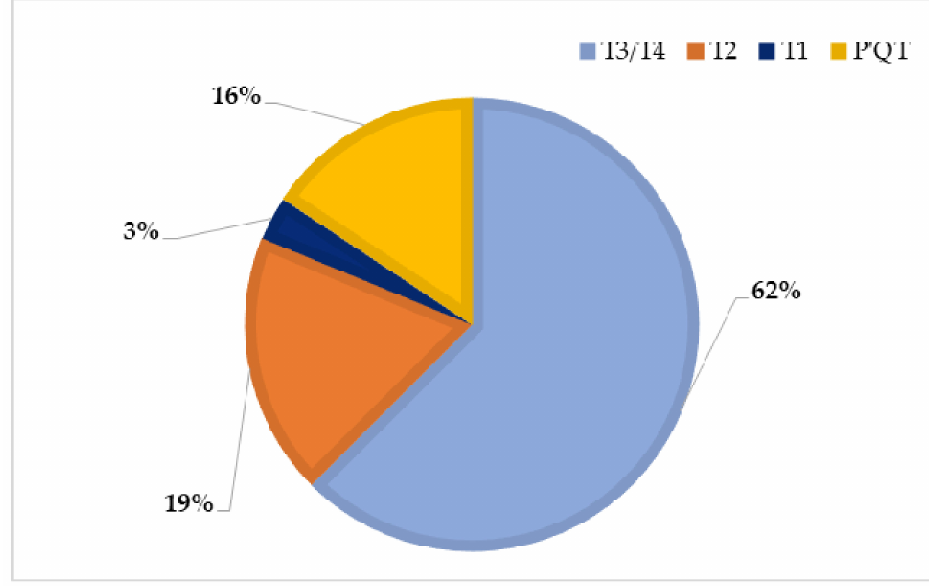
Figure 7. The frequency of haplotypes in Grey Steppe cattle population analyzed. The highest haplotype frequency was represented by the T3/T4 haplotype, which was identified in 20 analyzed individuals (62%): SS_02; SS_03; SS_04; SS_06; SS_07; SS_08; SS_09; SS_10; SS_12; SS_13; SS_14; SS_15; SS_16; SS_17; SS_20; SS_21; SS_23; SS_24; SS_29; and SS_31. Six individuals fell into the T2 haplotype, representing 19%: SS_01; SS_05; SS_18; SS_19; SS_28; and SS_33. The haplotype P (cid:48) QT was identified in five individuals, with a frequency of 16%: SS_22; SS_25; SS_26; SS_30; and SS_34. (This haplotype was also identified in the analysis of the nucleotide sequences from taurine specimens with direct descent from Bos taurus primigenius .) A single individual, SS_11, was included in the T1 haplotype, which had the lowest frequency at only 3% (Table